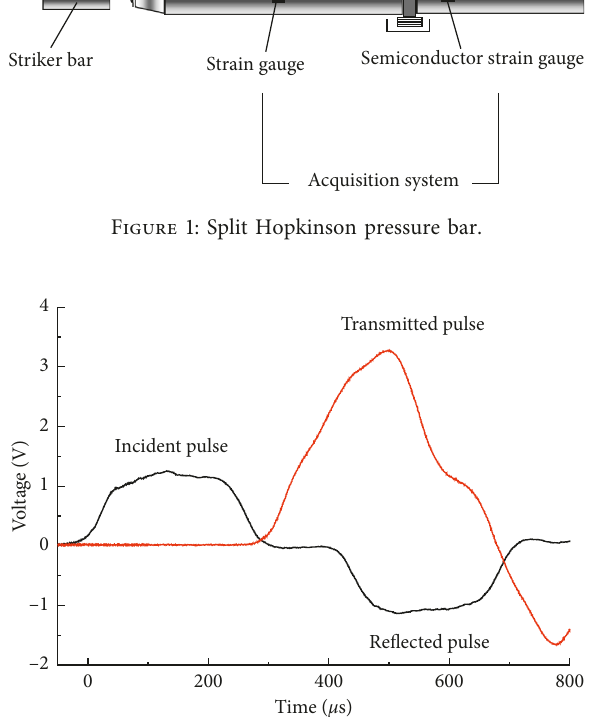
Figure 2: Typical shaped